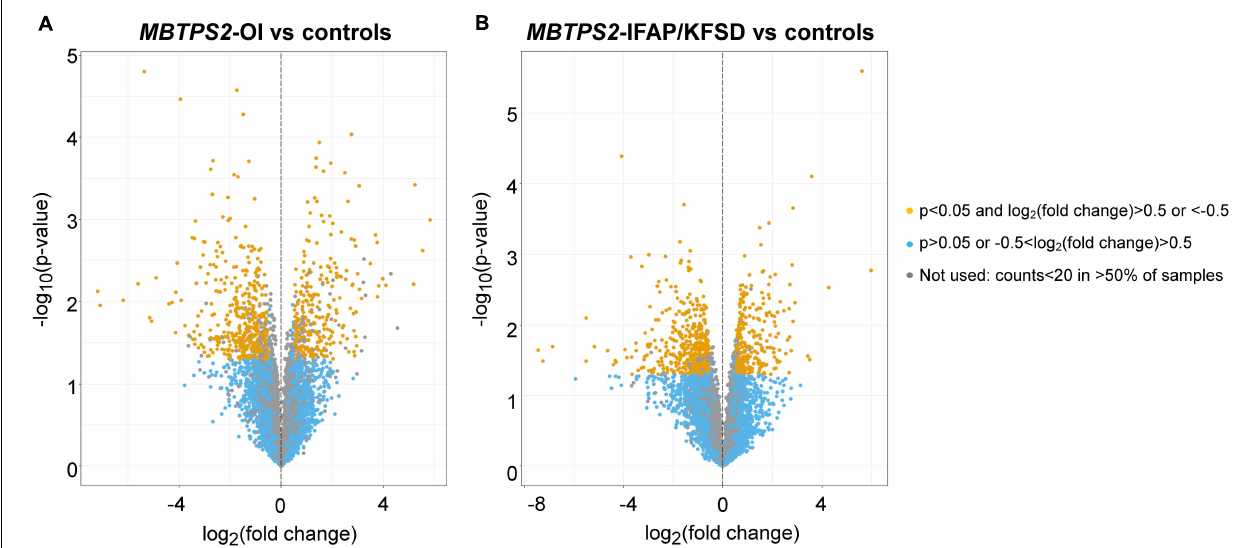
FIGURE 2 | Volcano plots of transcriptome profiles of panels (A) MBTPS2 -OI and (B) MBTPS2 -IFAP/KFSD patient-derived fibroblasts compared to healthy control fibroblasts.